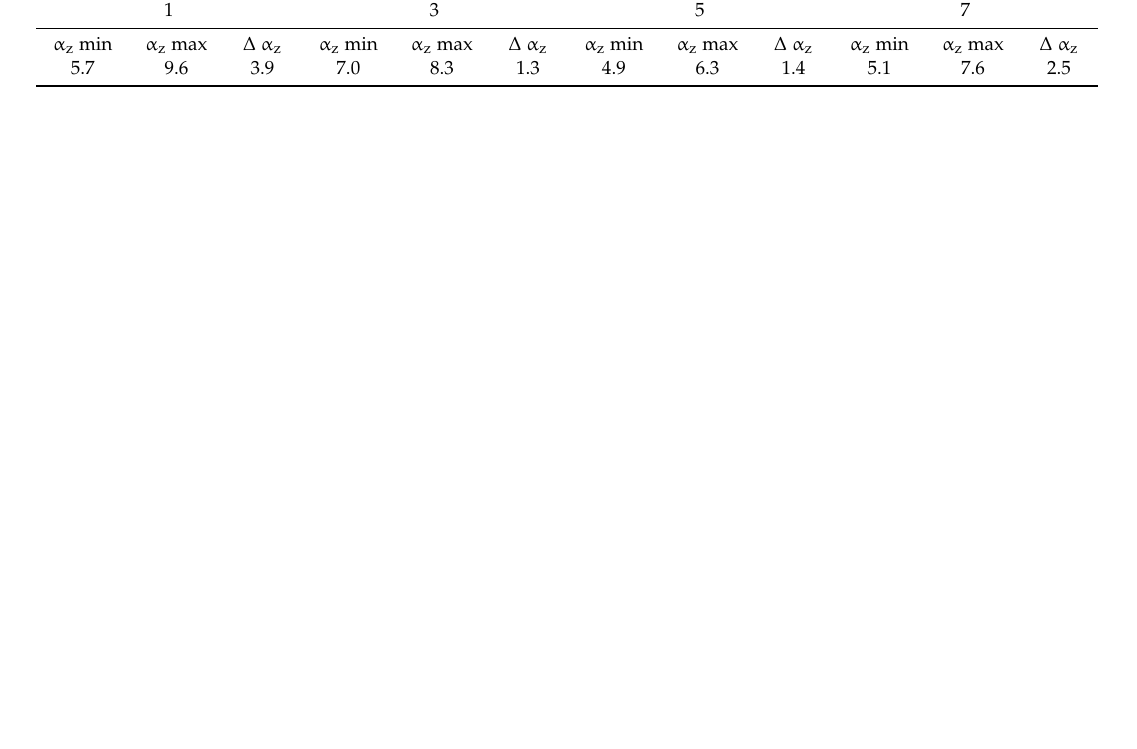
Table 5. Value of α z angle [°] between the [001] crystal direction and the direction of mold withdrawal.